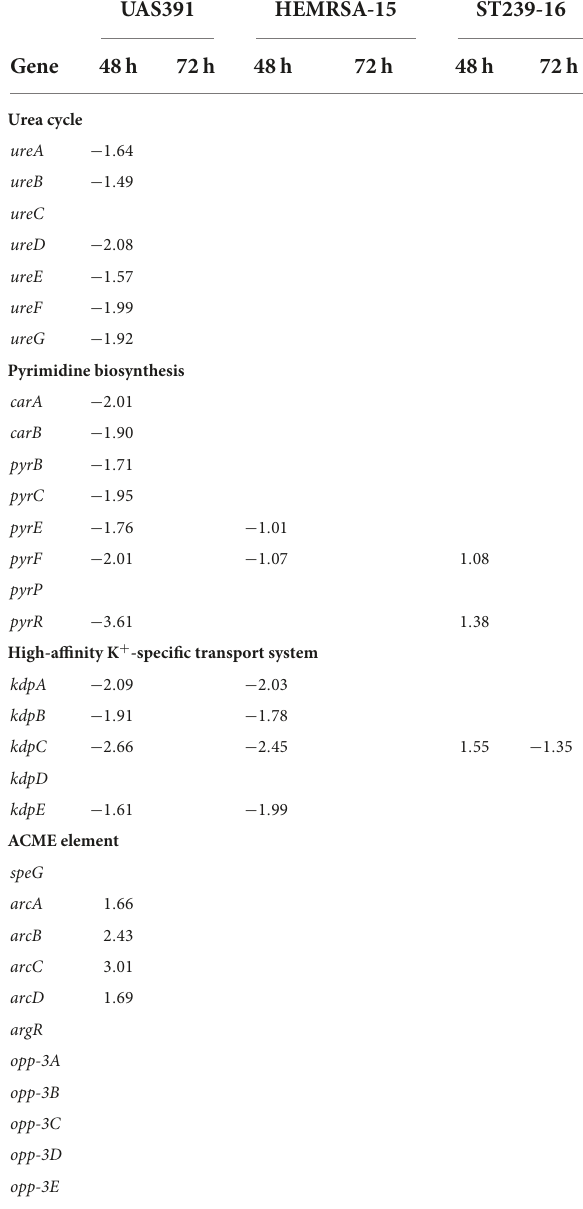
TABLE 3 Differentially expressed genes [log 2 (fold change)] of the urea cycle, pyrimidine biosynthesis, high-affinity K + -specific transport system, and ACME-associated genes (only in UAS391) in a biofilm of UAS391, HEMRSA-15, and ST239-16